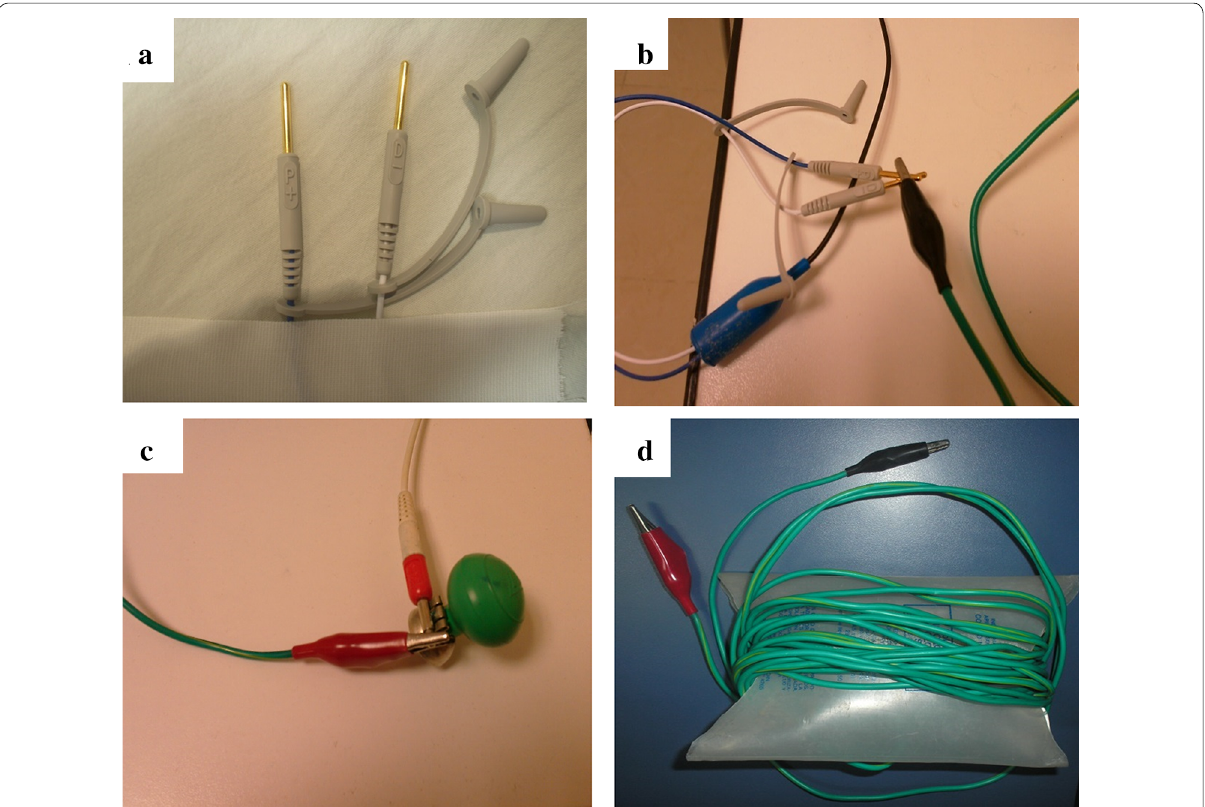
Fig. 3 Intracavitary electrocardiogram (ECG) technique attaching the electrodes of the EC ( a , b ) to a precordial lead (V1 in this case, c by a cable with an alligator clip on each end ( d ). Of note, while the alligator clip is attached to a precordial lead as seen by its suction cup, this is in fact registering the cardiac electrical activity from an intracavitary view, thus it is indistinct whether or not it is placed on the patient’s chest; ECG limb leads are placed in the usual fashion